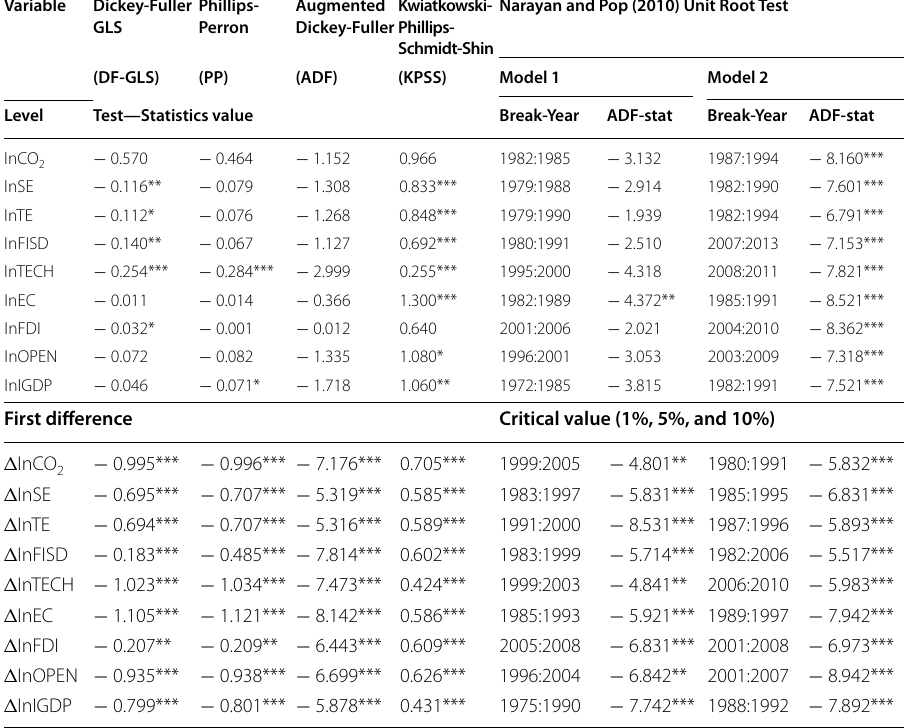
Table 4 Unit root analysis. Source : Authors’ calculations